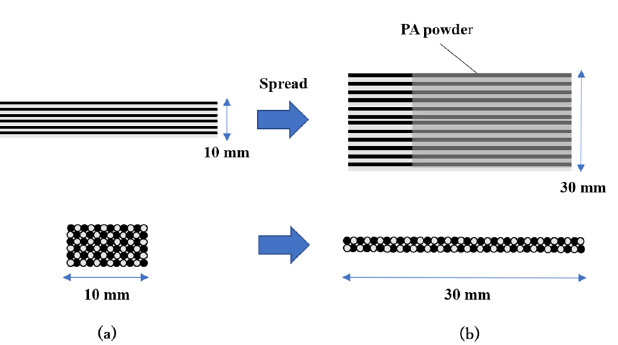
Figure 1. Image of spread of commingled yarn. ( a ) Standard commingled yarn; ( b ) Spread commin- gled yarn.